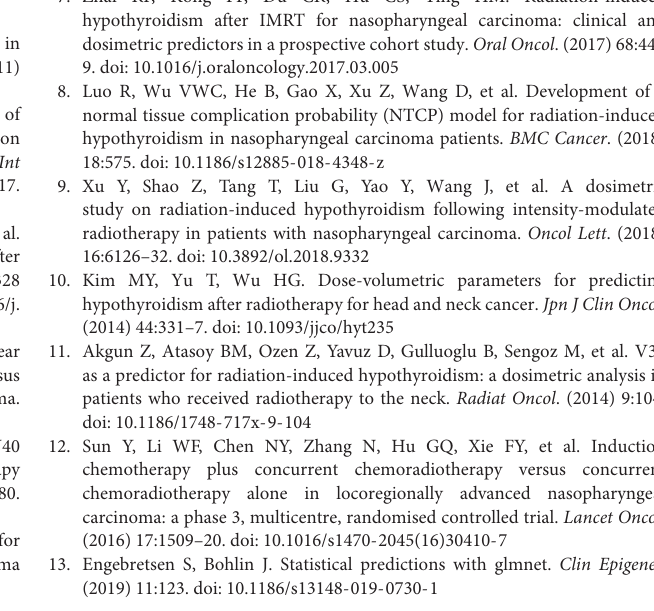
Supplementary Figure 1 | The distribution of thyroid volume of the